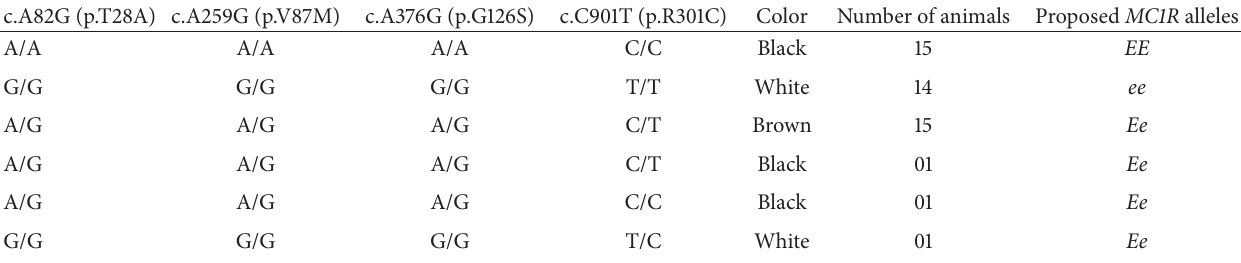
Table 3: The MC1R genotypes and phenotype of Peruvian